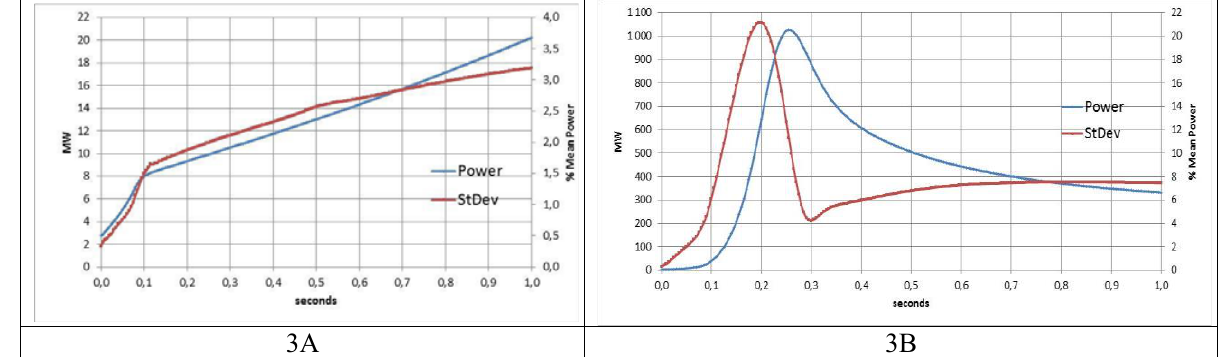
Figure 3: Mean Power (blue, MW) and Standard Deviation (red, % of mean power)